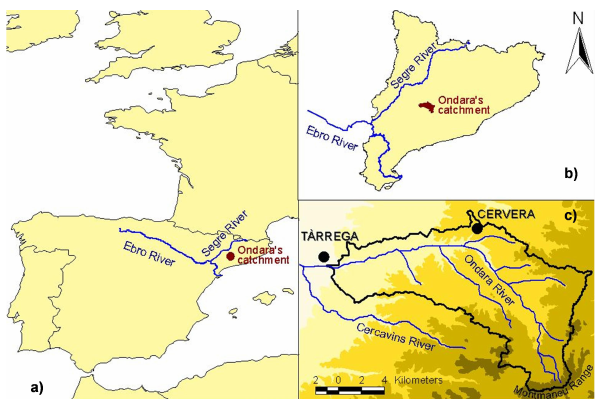
Fig. 2. T`arrega’s urbanized area evolution since the 17th century (a) and detail of Sant Agust´ı Street area (b)